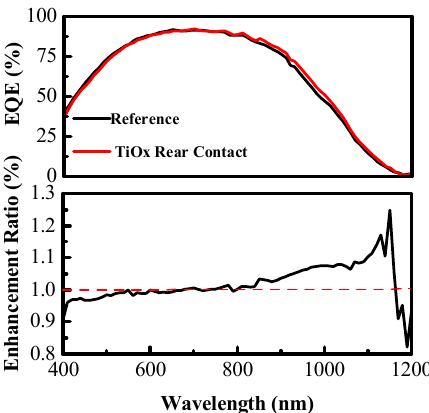
Figure 3. The external quantum efficiency (EQE) for the solar cells with and without a TiO x rear contact layer at wavelengths ranging from 400 to 1200 nm ( upper ). Enhancement of EQE for the solar cells with and without TiO x rear contact layer calculated from the EQE spectrum ( lower ).